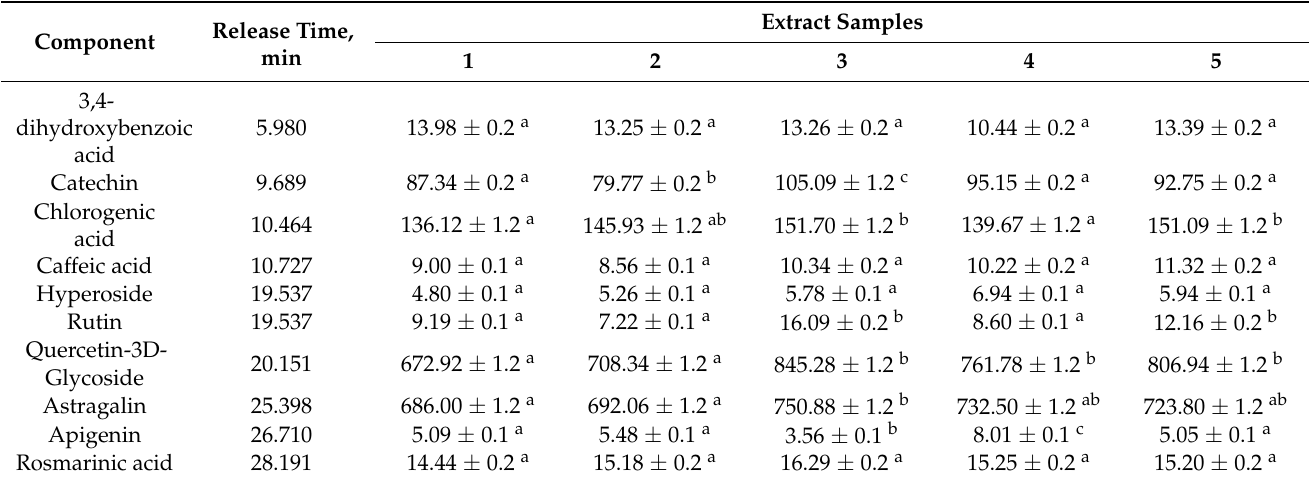
Table 3. Concentration of substances ( µ g/mL) in samples of E. globulus extract with different extraction times (without US